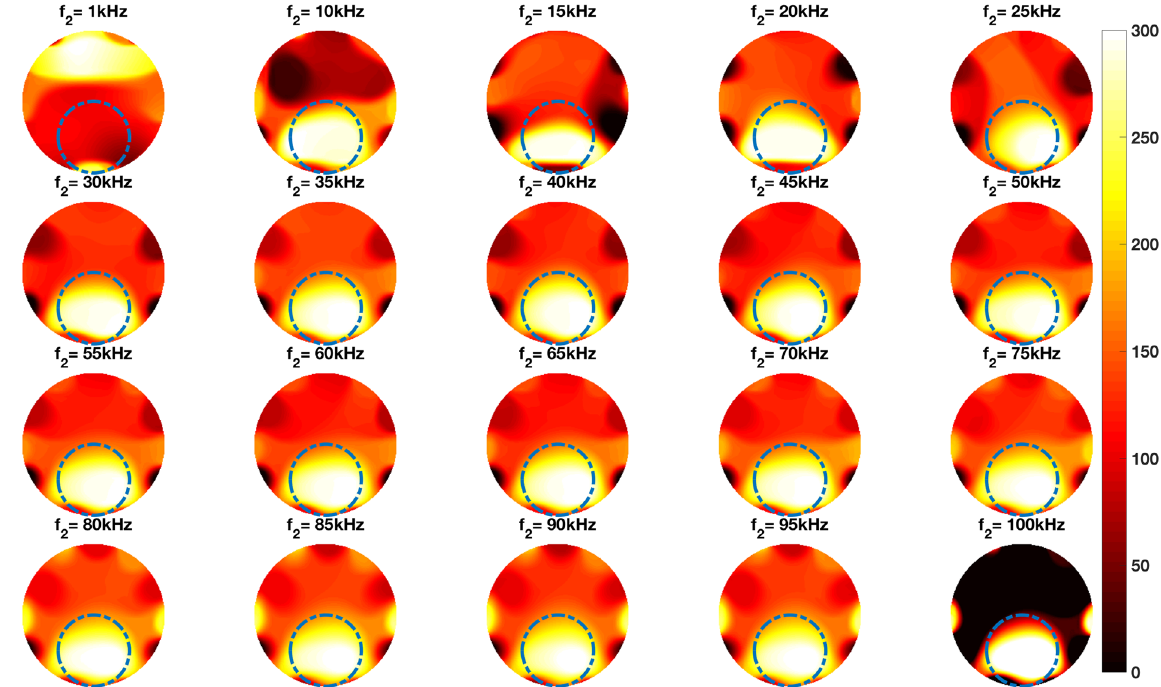
Figure 7. Reconstructed frequency difference images of an aluminium tube (OD50.76 mm) and a steel tube (OD50.76 mm) positioned side by side in the imaging region (experimental setup shown in Fig. 5B).